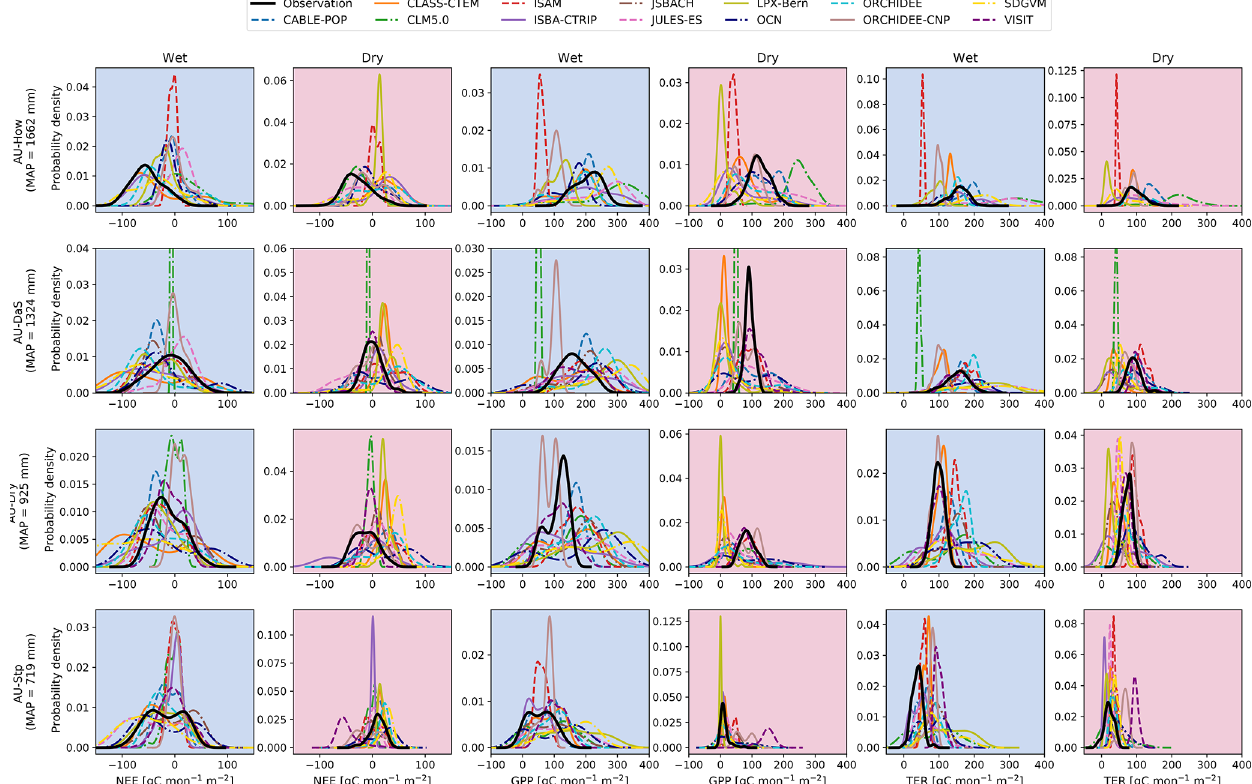
Figure 6. Probability density functions for observed and modelled net ecosystem exchange (NEE), gross primary production (GPP), and terrestrial ecosystem respiration (TER) for the for four flux sites: Howard Springs (AU-How), Daly Uncleared (AU-DaS), Dry River (AU- Dry), and Sturt Plains (AU-Stp). These sites reflect a strong mean annual precipitation (MAP) gradient (provided for each row). We show the monthly distribution of each variable for the wet (November–April) and dry (May–October) seasons. The observed variables originate from eddy covariance data collected by the TERN-OzFlux facility. The probability density function is based on kernel density estimates using Gaussian kernels with bandwidth selection following Scott